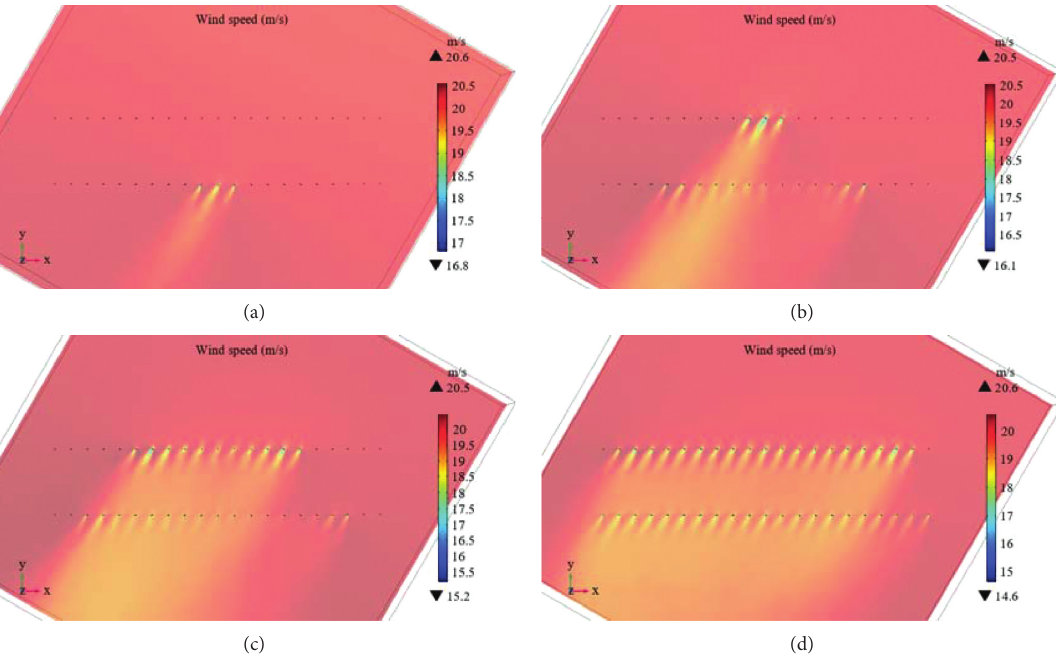
Figure 11: Influence of height for wind field (wind direction � 210 ° /330 ° ). (a) 210 ° /330 ° , z � 10m. (b) 210 ° /330 ° , z � 5m. (c) 210 ° /330 ° , z � 3m. (d) 210 ° /330 ° , z �